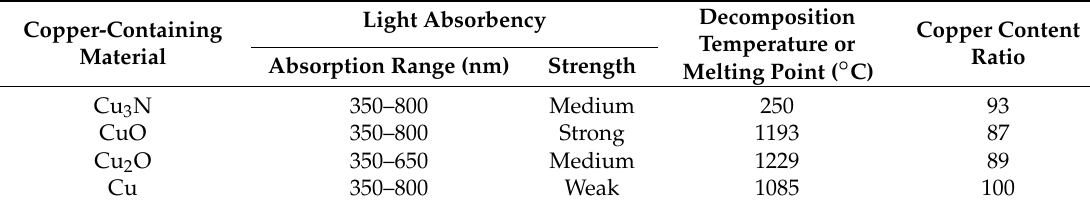
Figure 2. Thermogravimetric-differential thermal analysis curves of copper nitride (Cu 3 N), copper(I) oxide (Cu 2 O), and copper(II) oxide (CuO) in an air or N 2 atmosphere. Table 1. Chemical properties of the copper-containing